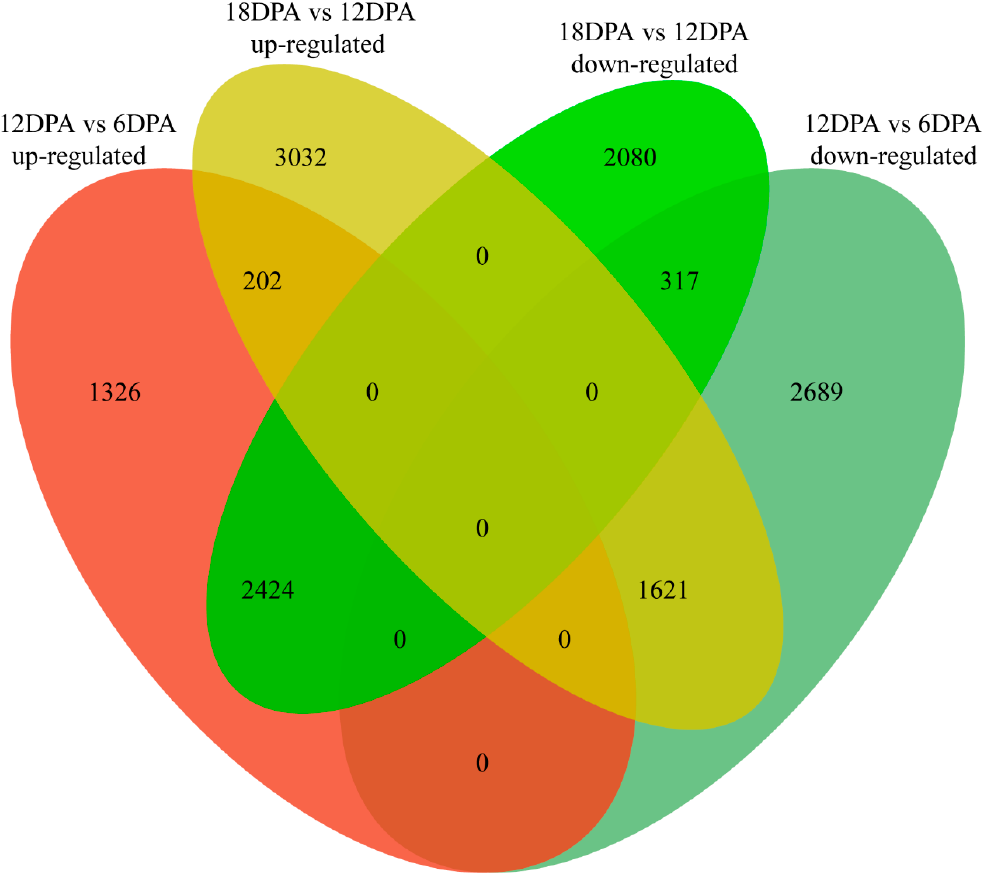
Figure 3. Statistics of differentially expressed genes between the Gossypium stocksii fibers of 6, 12 and 18 DPA. 18